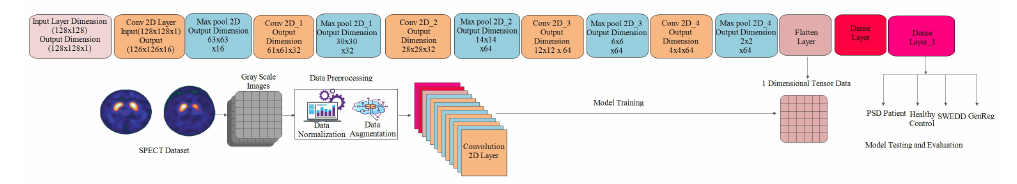
Figure 3. Proposed